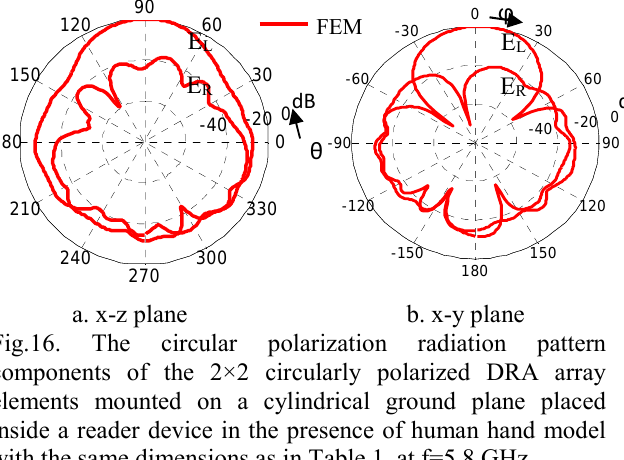
Fig.16. The circular polarization radiation pattern components of the 2×2 circularly polarized DRA array elements mounted on a cylindrical ground plane placed inside a reader device in the presence of human hand model with the same dimensions as in Table 1, at f=5.8